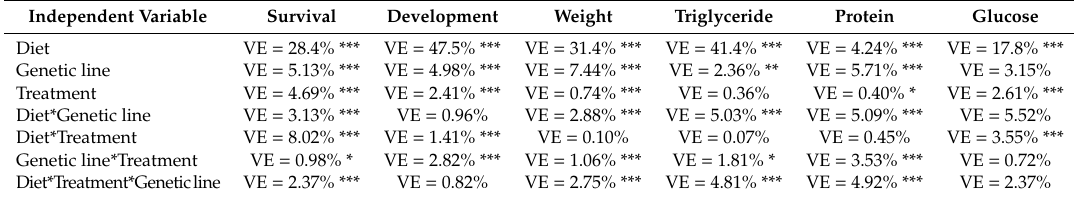
Table 3. The contribution of diet, genotype, treatment, and their interactive effects on formation of larvae life history traits and metabolic phenotypes. VE stands for variance explained, by each independent variable. Asterisks indicate the significance of comparisons p < 0.001 ***, p < 0.01 **, and p < 0.05